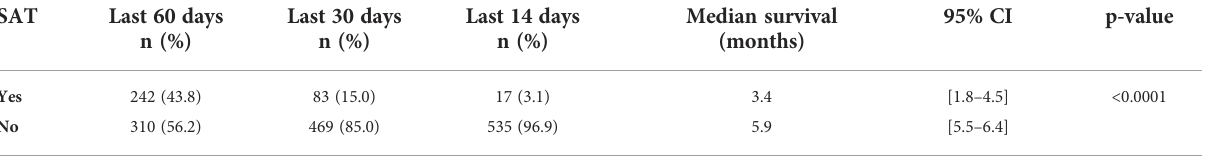
TABLE 3 Systemic anticancer treatment (SAT) at the end of life.